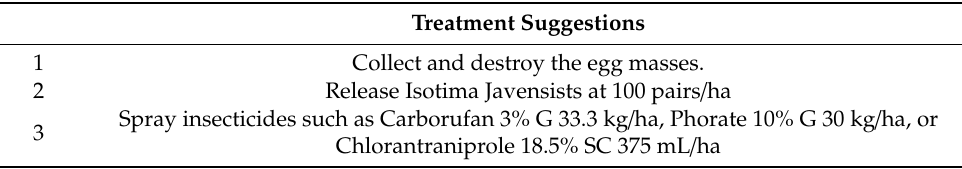
Table 4. Treatment suggestions for Scripophaga excerptalis